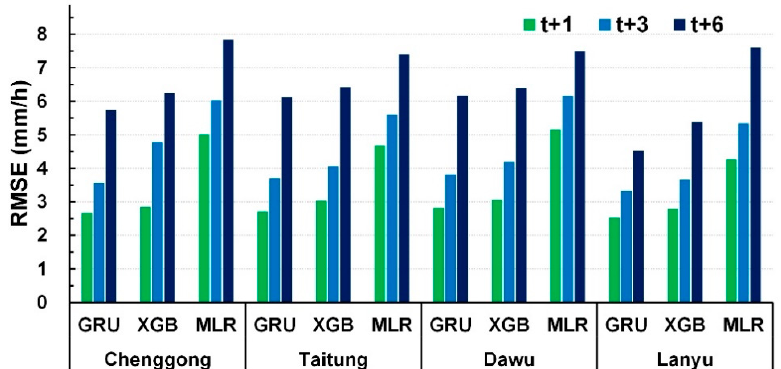
Figure 7. Comparison of RMSE values of GRU, XGB, and MLR prediction models (average results of 10 scenarios).